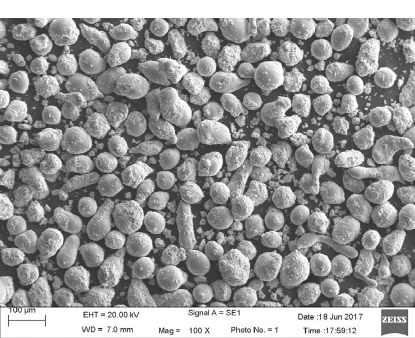
Figure 2: Morphology of NiCoCrAlY powder particle. Table 3: Thermophysical properties of CGI and